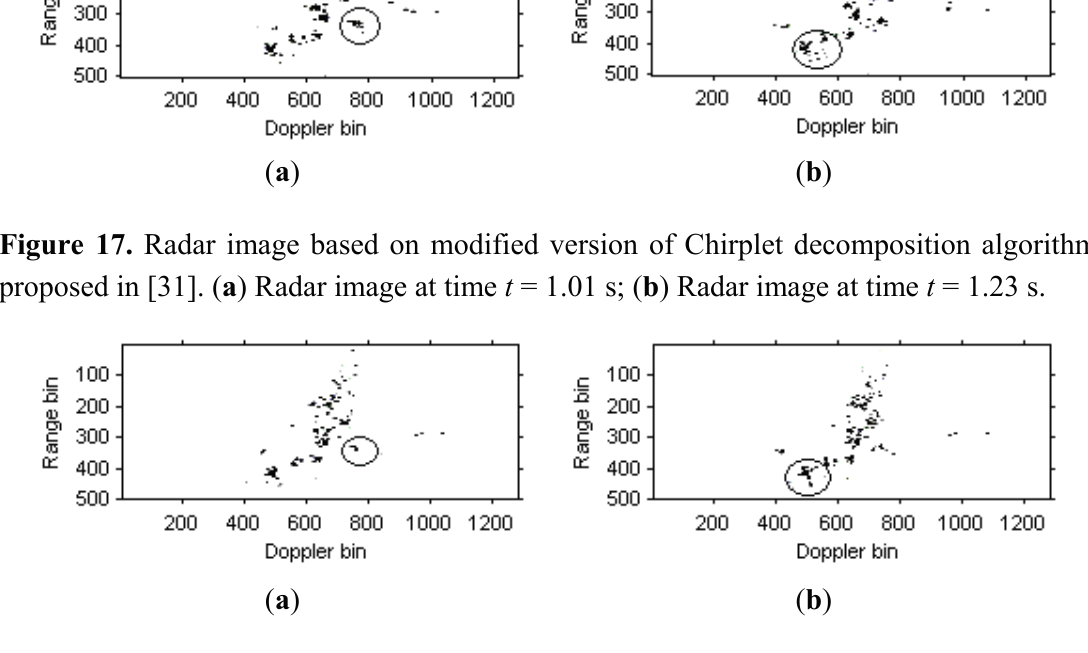
Figure 18. Radar images based on modified version of Chirplet decomposition algorithm proposed in this paper. ( a ) Radar image at time t = 1.01 s; ( b ) Radar image at time t = 1.23 s.